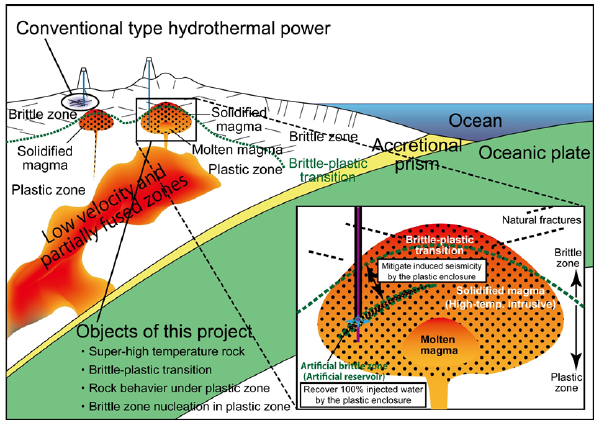
Figure 5. The principles behind the Japan Beyond the Brittle Project (JBBP). Figure courtesy of H. Asanuma (National Institute of Advanced Industrial Science and Technology, AIST), Japan.